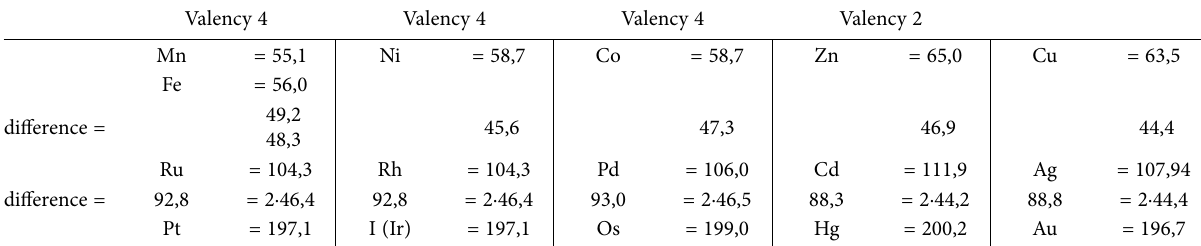
Figure 4. Groups of six elements with the difference of nearly 46 of atomic weights and the valency two, four and mixed. Adapted from